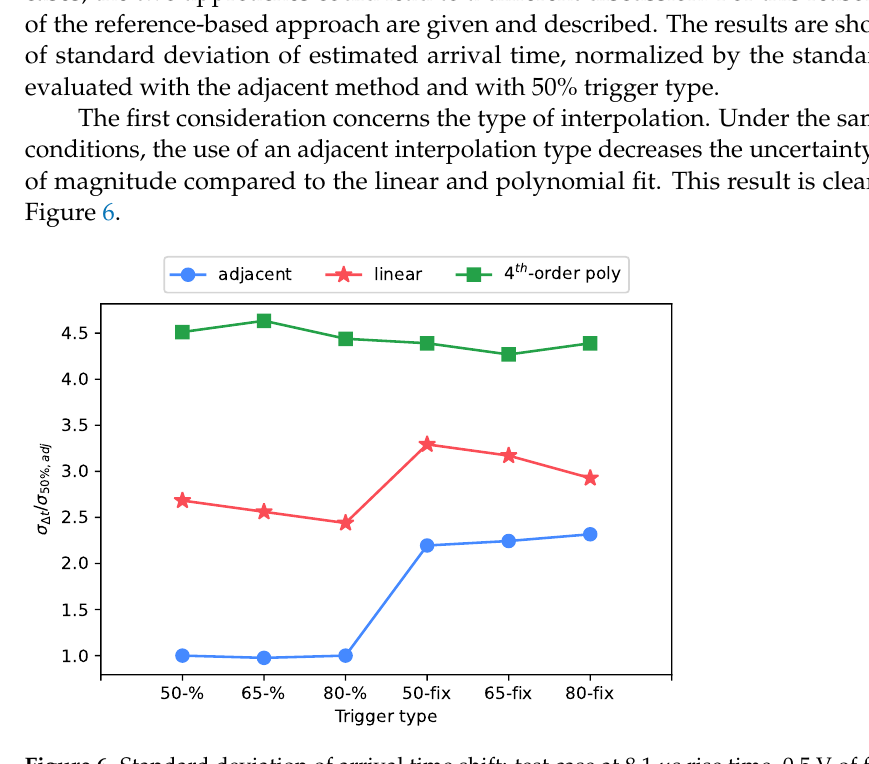
Figure 6. Standard deviation of arrival time shift: test case at 8.1 µ s rise time, 0.5 V of full scale